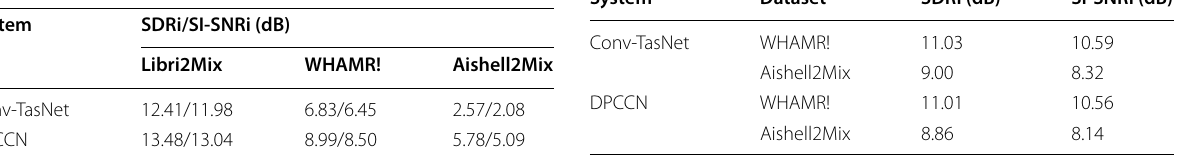
Table 2 SDRi/SI-SNRi (dB) performance of Conv-TasNet and DPCCN on Libri2Mix, WHAMR!, and Aishell2Mix test sets. Systems are all trained on Libri2Mix